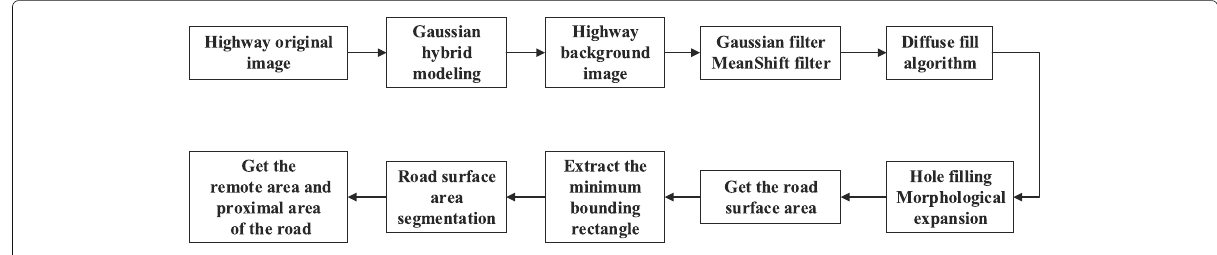
Fig. 5 Overall flow of road surface extraction